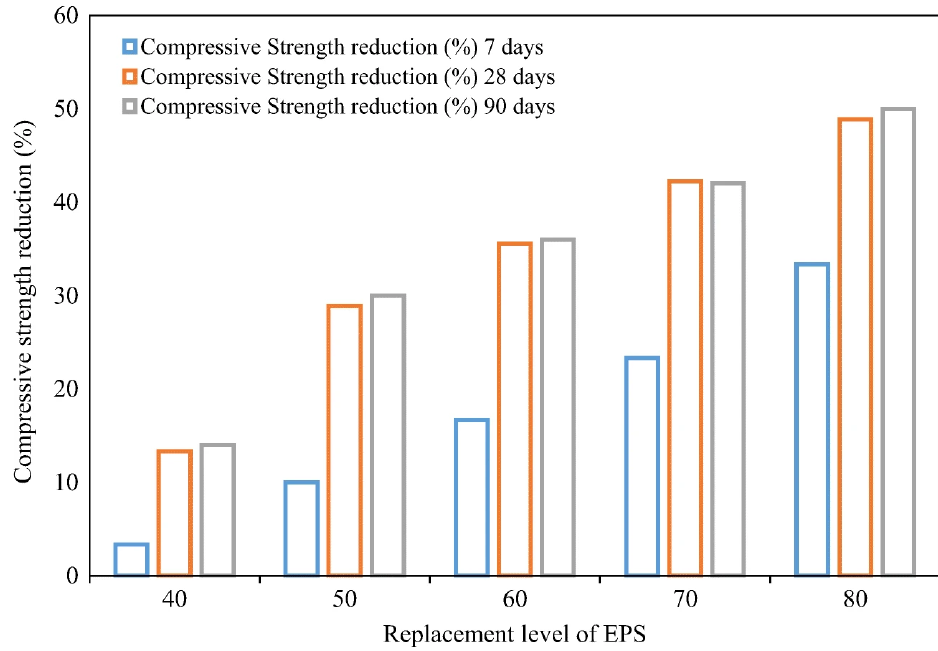
Figure 27. Variation in the reduction of compressive strength (%) in self-consolidating lightweight concretes as the typical coarse river aggregate was replaced with 40, 50, 60, 70 and 80% EPS beads. Reprinted from ref. [69].